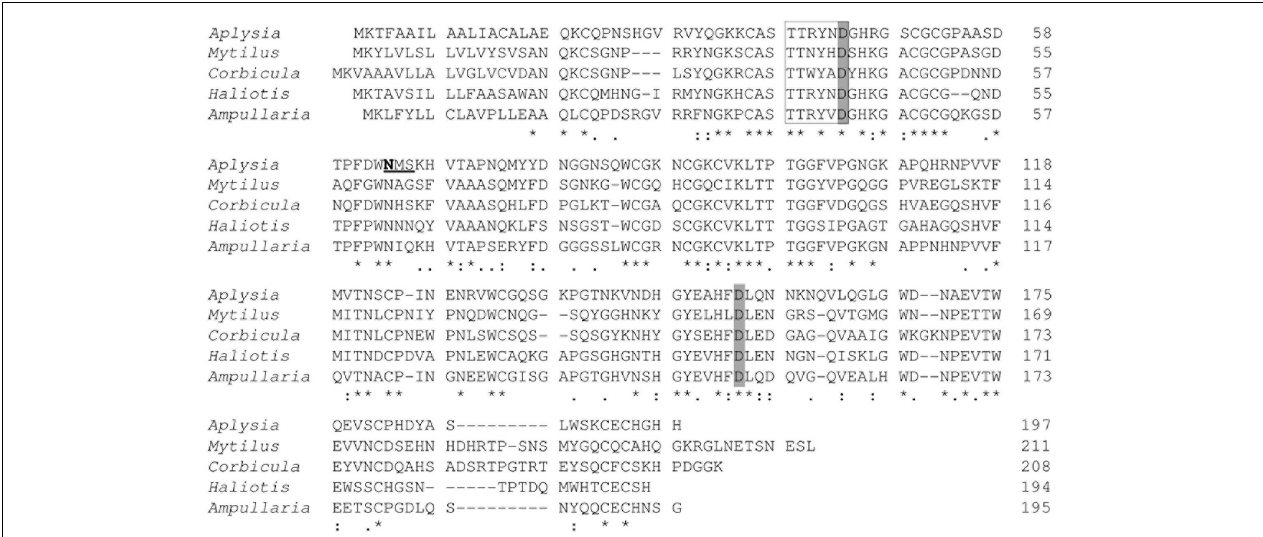
FIGURE 6 | Alignment of the amino-acid sequences of AkEG21 and other molluscan GHF45 cellulases. The amino-acid sequence of AkEG21 (DDBJ accession number, AB920344) was aligned with those of endoglucanase (Eg) from M. edulis (DDBJ accession number, CAC59694), CjCel45A from C. japonica (DDBJ accession number, AB468959), endo- β -1,4-glucanase 1 from H. discus discus (DDBJ accession number, EF103350), and EG27I from